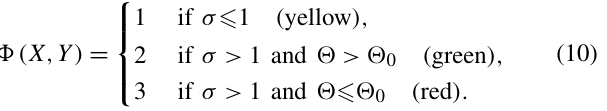
abrupt transition from NPBAs, with (cid:104) (cid:50) (cid:105) (cid:48) (cid:39) 1, to CPBAs oc- curs at ε c ∼ = 0 . 09. Many additional analyses (not shown) for values just below and above ε c confirm that this is in fact the critical value beyond which chaos sets